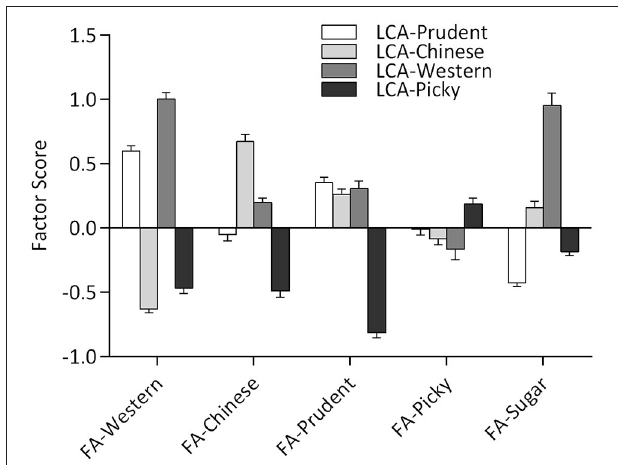
FIGURE 2 | Factor scores’ means by latent class, four classes on five factor